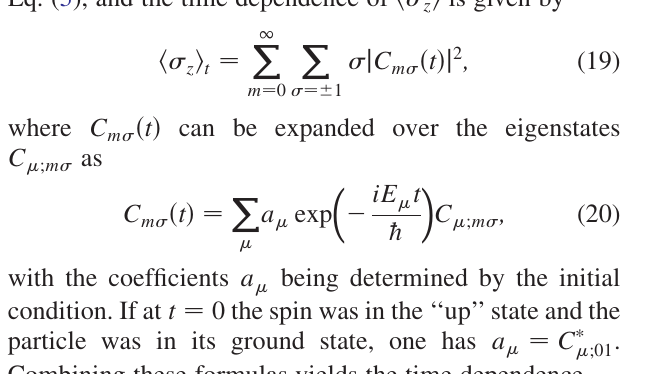
Fig. 2. Fast oscillations with a frequency close to (cid:1) tend to disappear and reappear with time due to the coupling of the spin to a quasicontinuum of the oscillator modes. The recurrence of the oscillations (which is not seen for r ¼ 0 : 01 within the plotted time interval) reflects the fact that the oscillator modes are not fully continuous. Fast damped oscillations correspond to the peaks in the Fourier spectrum at @ ! ¼ (cid:1) in Fig. 4. For (cid:3) ¼ 0 : 5 and 1 in Fig. 5, there are slow oscillations at larger times due to the rotation of the spin together with the nanoresonator. These slow oscillations correspond to the low-frequency peaks in Fig. 4. They occur by virtue of the restoring force that violates conservation of the total angular momentum ¼ L þ S(cid:1) J . One can clearly see this in Fig. 6, where z z z fast tunneling oscillations that conserve J are absent. z